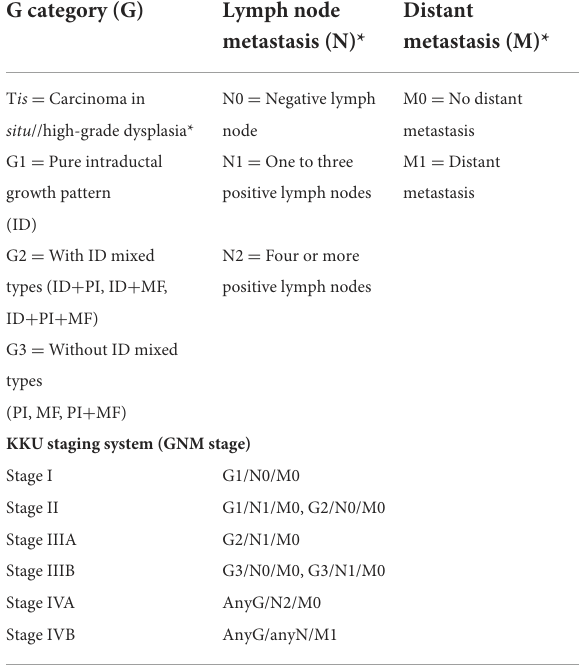
TABLE 4 Definition of GNM categories of the KKU staging